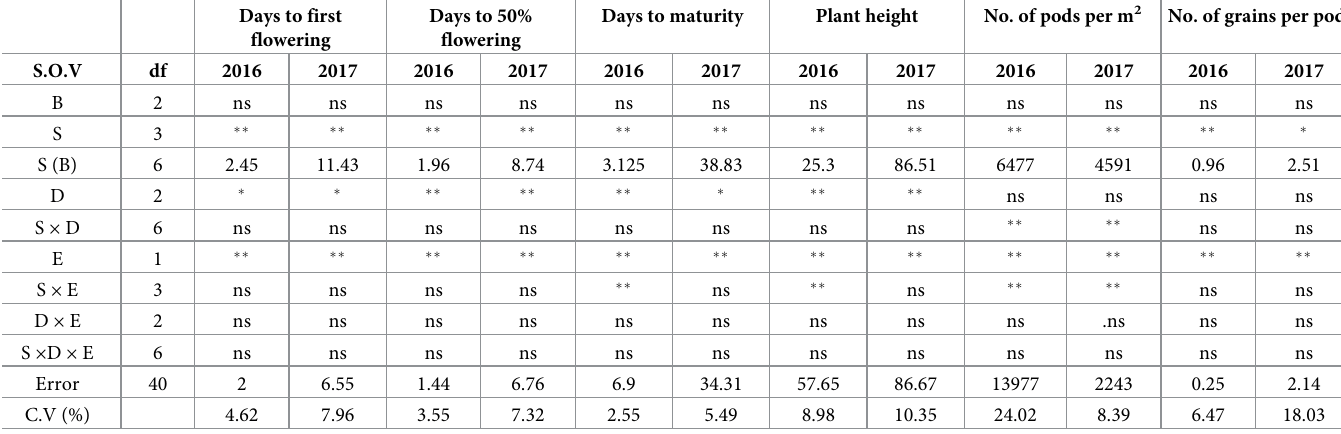
Table 2. Analysis of variance on morphological and phenological traits affected by sowing date, plant density and ecotype in 2016 and 2017. Days to first flowering